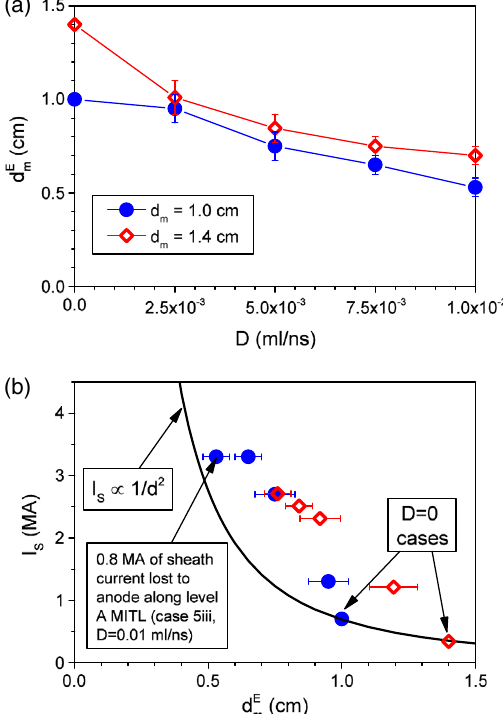
FIG. 5. Spatially averaged ion density profiles in the A MITL for (a) d m ¼ 1 cm and (b) d m ¼ 1 . 4 cm. The approximate effective cathode position in the gap for each case is indicated by the black point.